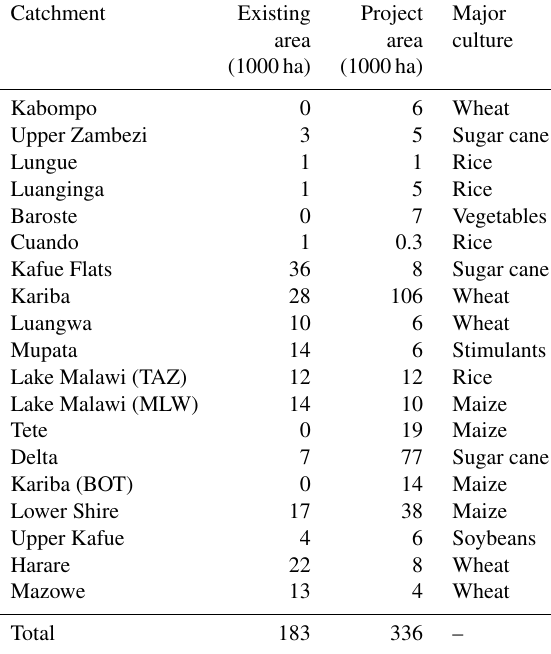
Table 3. Irrigation development projects. The irrigation develop- ment projects are aggregated per catchment. Areas are expressed in terms of “equipped area” which accounts for the land use.